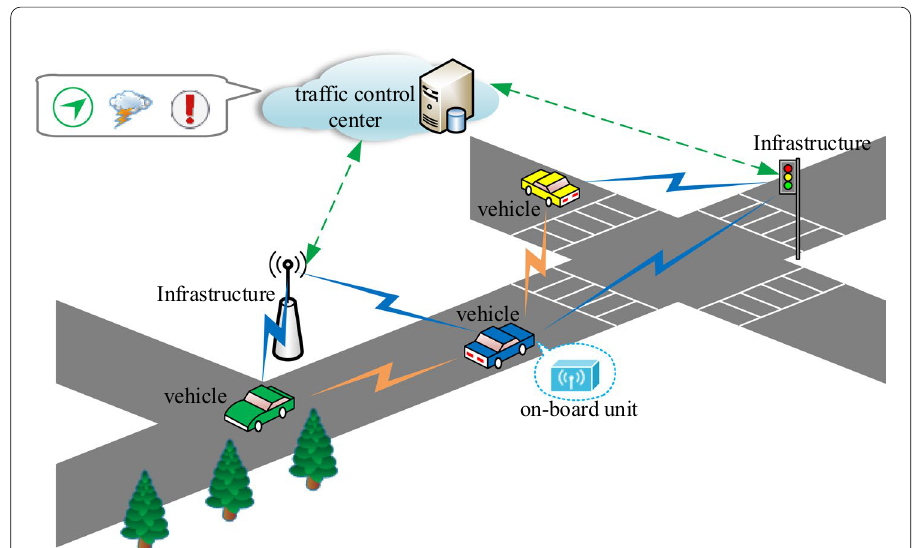
Fig. 1 Traditional structure of a vehicular